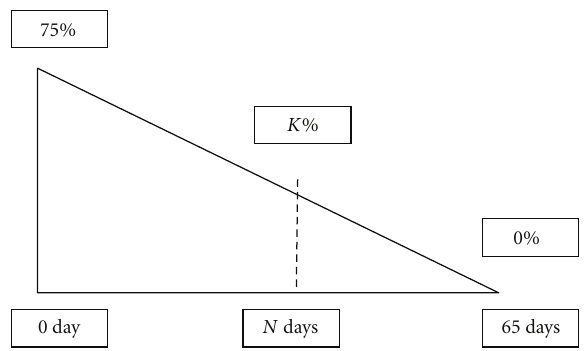
Figure 4: The method to determine the harvesting days.